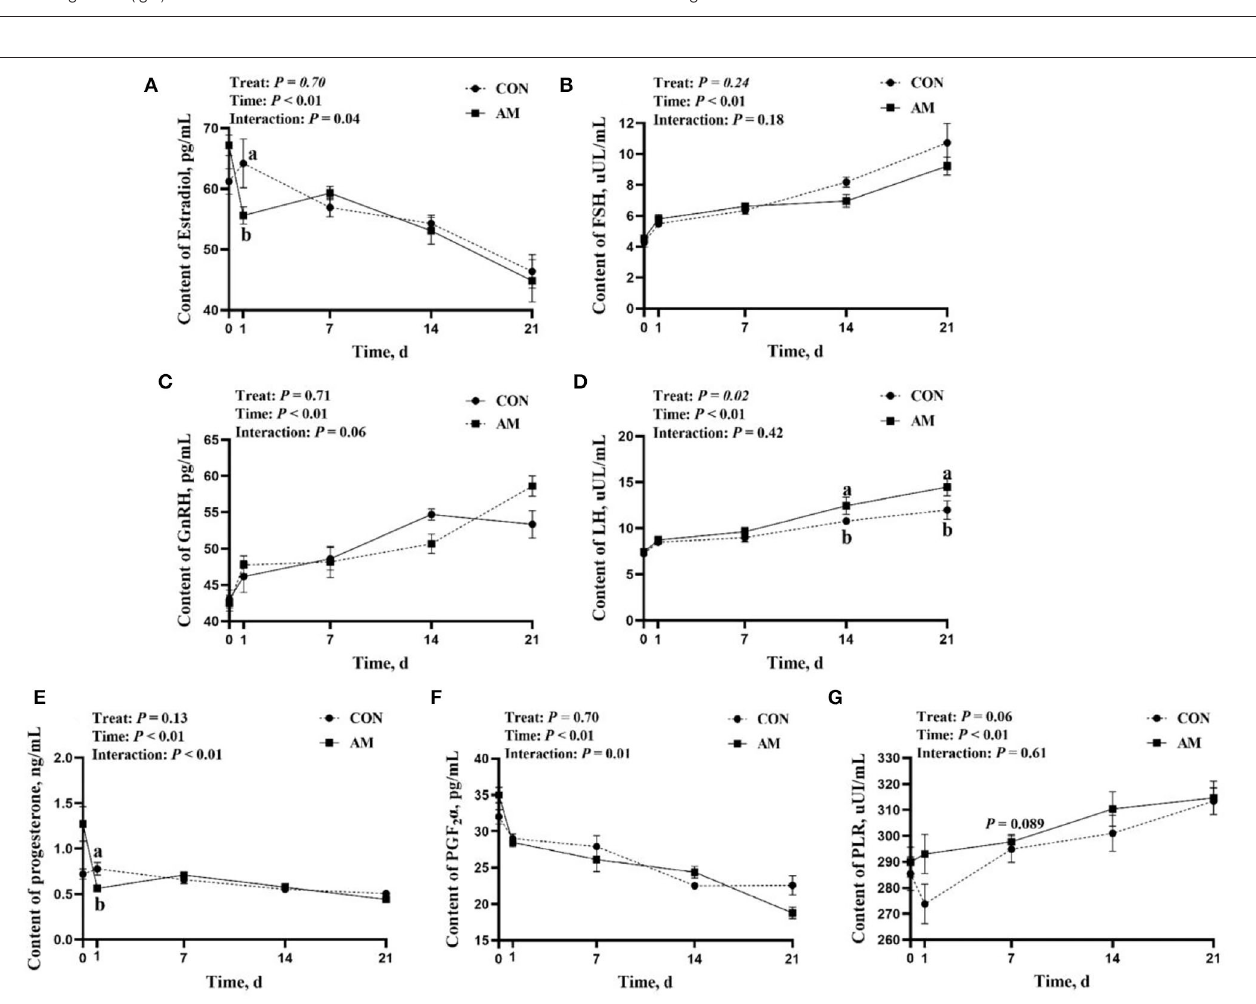
FIGURE 4 | Reproductive hormones of CON and AM in Holstein dairy cows at 21 days postpartum (A) Estradiol, (B) Follicle stimulating hormone, (C) Gonadotropin-releasing hormone, (D) Luteinizing hormone, (E) Progesterone, (F) Prostaglandin 2 α , (G) Prolactin.